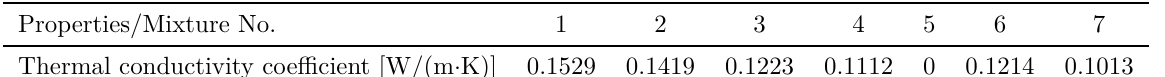
Properties/Mixture No.